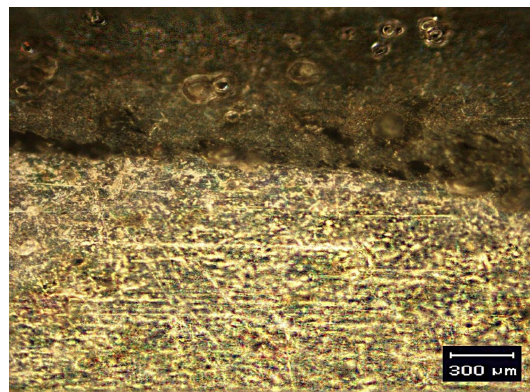
O -included specimen. 2 3